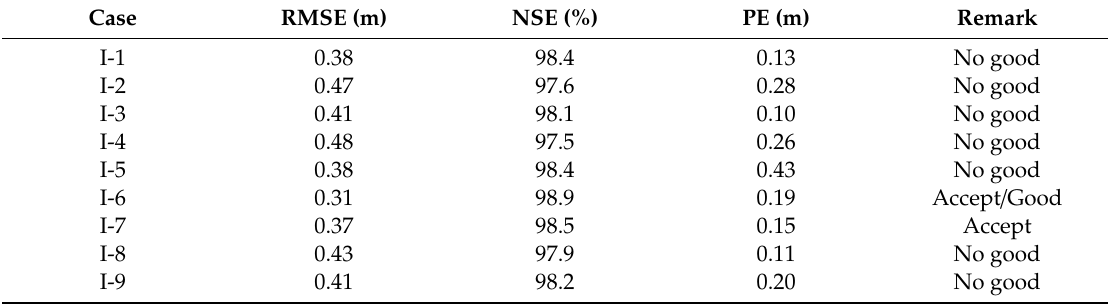
Table 7. Summary of accuracy for various weights in Scenario I (Period: 5–7 July 2016, about 50